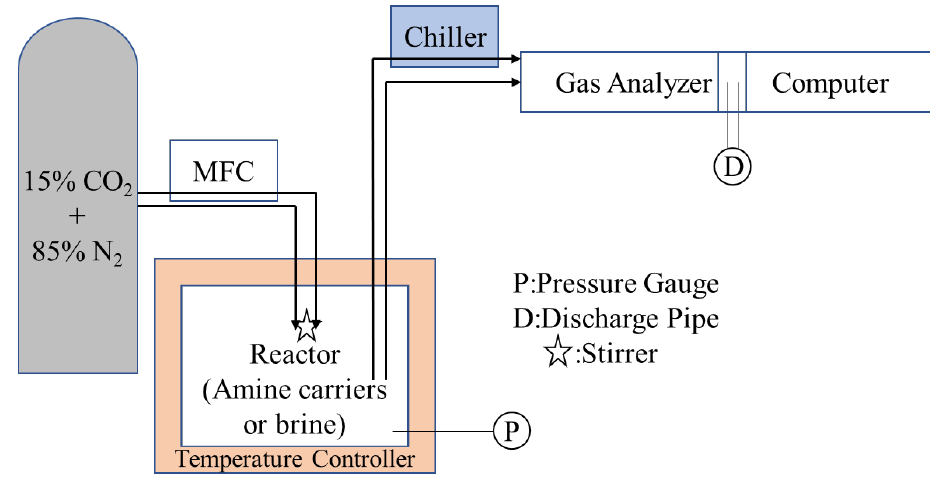
Figure 2. The CO 2 adsorption system in this study.